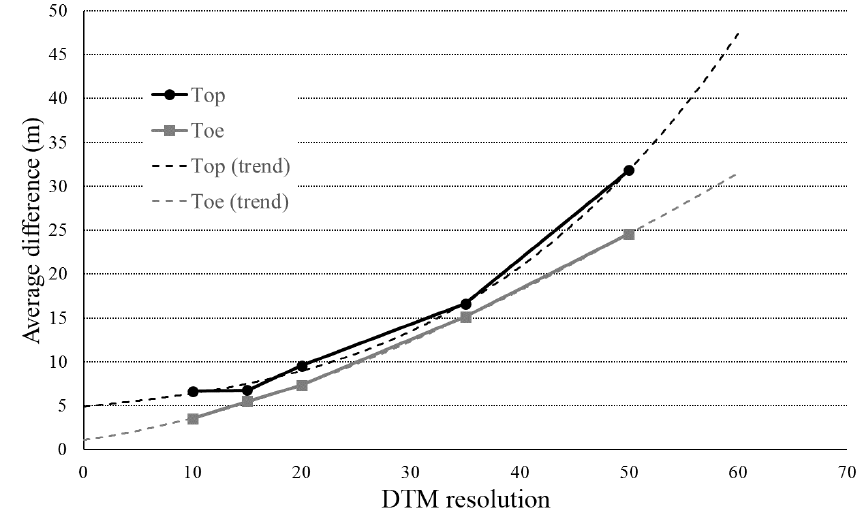
Figure 10. The cliff metric outputs (top and toe locations) average difference decreases as the DEM resolution